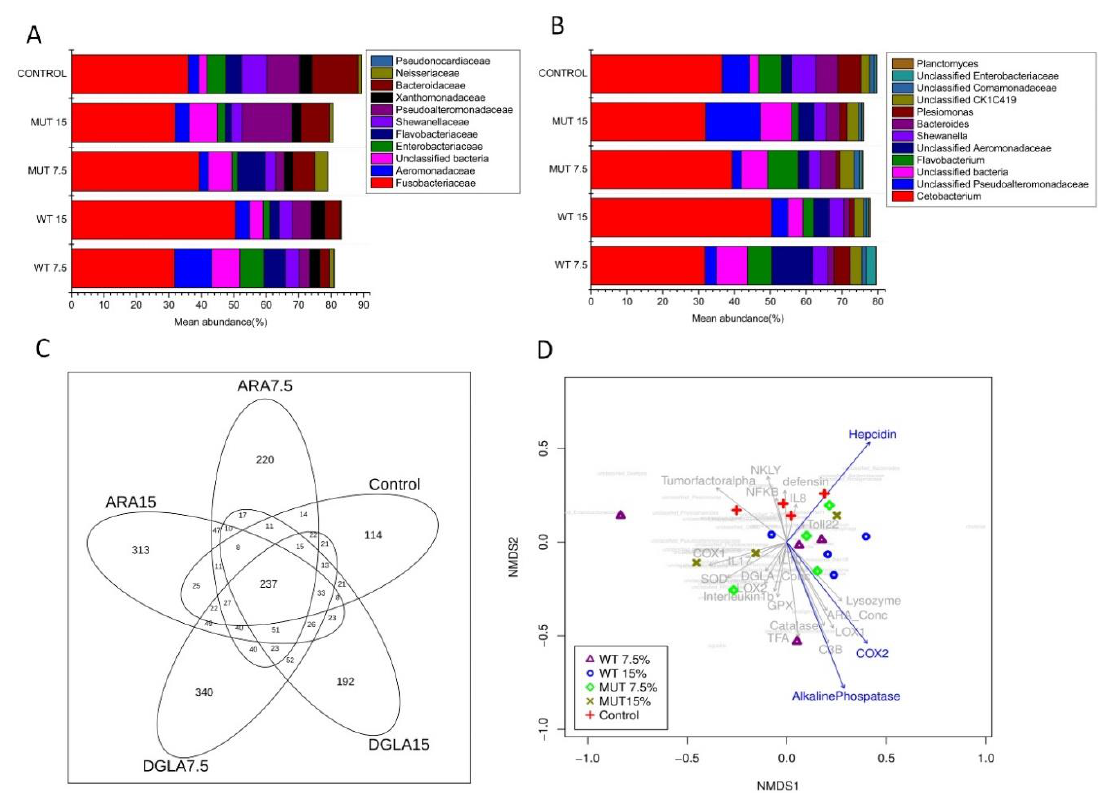
Figure 9. Relative abundance of bacteria at the family ( A ) and genus ( B ) levels in the gut of zebrafish fed different diets. Values for average relative abundance (%) of only the dominant families or genera obtained after taxonomic assignment of bacterial 16S rRNA gene sequences are shown. Individual phyla are indicated by different colors. ( C ) Venn diagram showing unique and shared bacterial OTUs at 97% sequence similarity among different dietary treatment groups. The numbers in the overlapping circles indicate OTUs shared by the experimental groups. ( D ) Nonparametric multidimensional scaling (NMDS) ordination illustrating the effects of different dietary supplementation (WT, MUT at 7.5 and 15%, and control) on fish gut bacterial community. The plot also includes the tested significant and nonsignificant immune gene expression profiles (blue and gray arrows, respectively) and the microbial species distribution (97% of total species abundance, in light gray in the background).